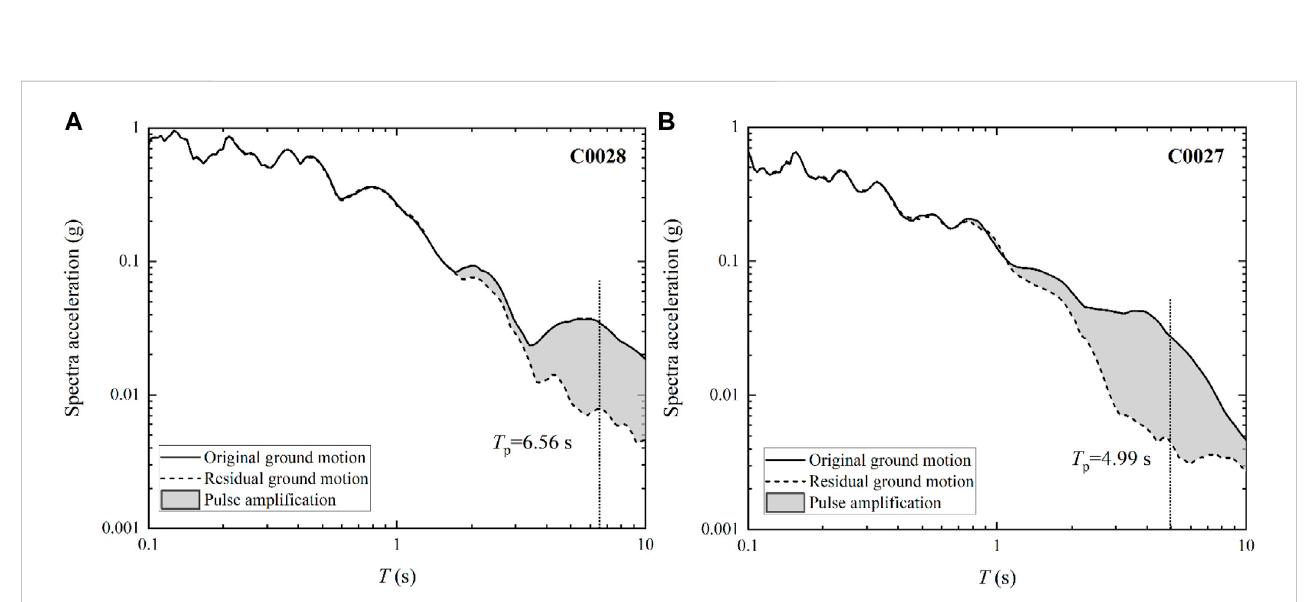
FIGURE 12 Comparison of the acceleration response spectra of the original pulse-like and non-pulse residual ground motion. (A) C0028; (B) C0027.